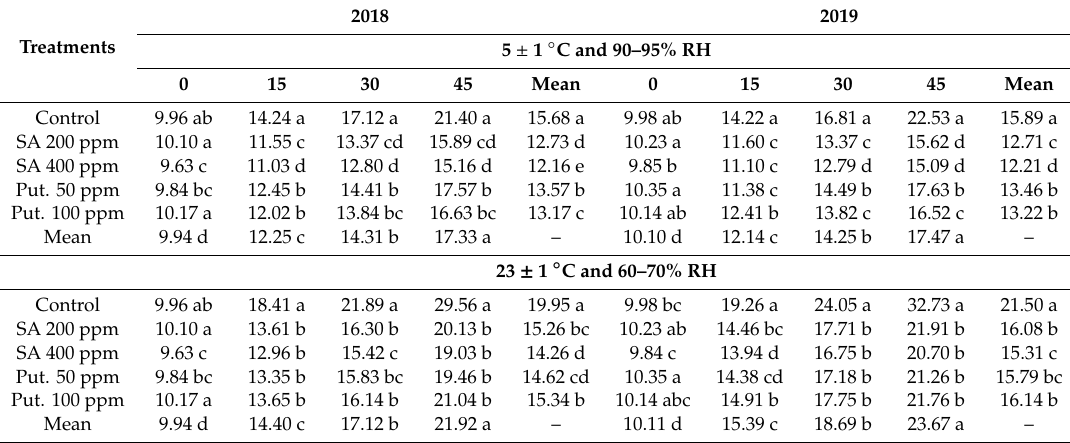
Table 6. E ff ect of salicylic acid (SA) and putrescine (Put) on TSS: acid ratio of Murcott mandarin fruit at harvest and 15, 30, and 45 days of storage during 2018 and 2019